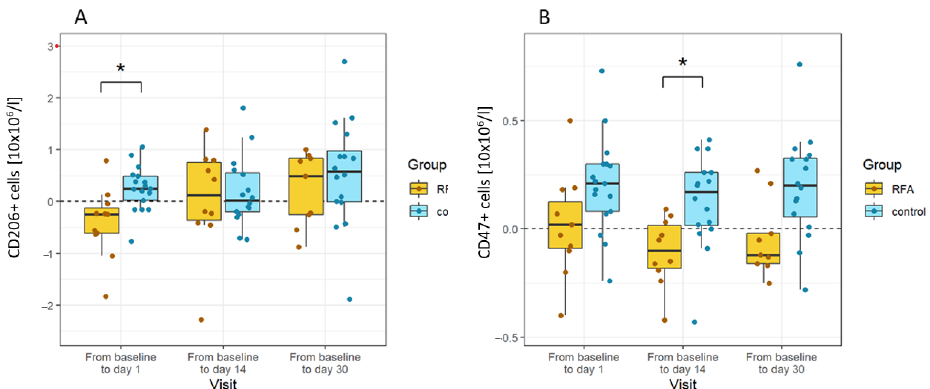
Figure 5. Changes in cells specific to RFA in CCC patients. ( A ) The number of CD206+ cells decreased shortly after the procedure in the RFA-treated patients compared to the controls (day 1). ( B ) The number of CD47+ was greater than the controls at all time points, and the difference was statistically significant on day 14. Absolute differences from baseline are plotted for different visits using box and whisker plots. The line in the middle of the box represents the median; the upper and lower ends of the box represent the first and third quartiles, respectively, excluding outliers. The upper and lower whiskers show the maximum and minimum scores, respectively. Individual dots represent individual patients’ values. Asterisks show the statistical significance. The x -axis shows the fold difference between values at each visit vs. baseline values before treatment.